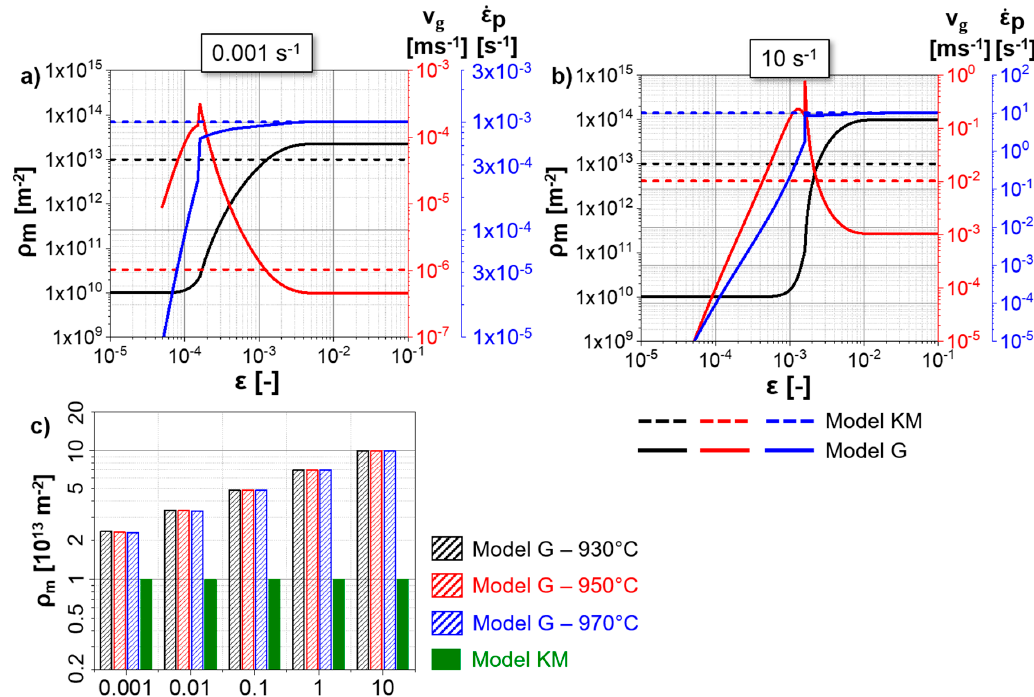
Figure 11. Evolutions of the mobile dislocation density, glide velocity and plastic strain rate predicted by “Model G” for Ti-17 deformed at 970 °C and ( a ) 0.001 s − 1 , ( b ) 10 s − 1 ; ( c ) steady-state mobile dislocation density predicted for the of the Ti-17 using “Model G” for different strain rates and temperatures and the comparison with the assumed invariable mobile dislocation density of 10 13 m − 2 for the “Model KM”.